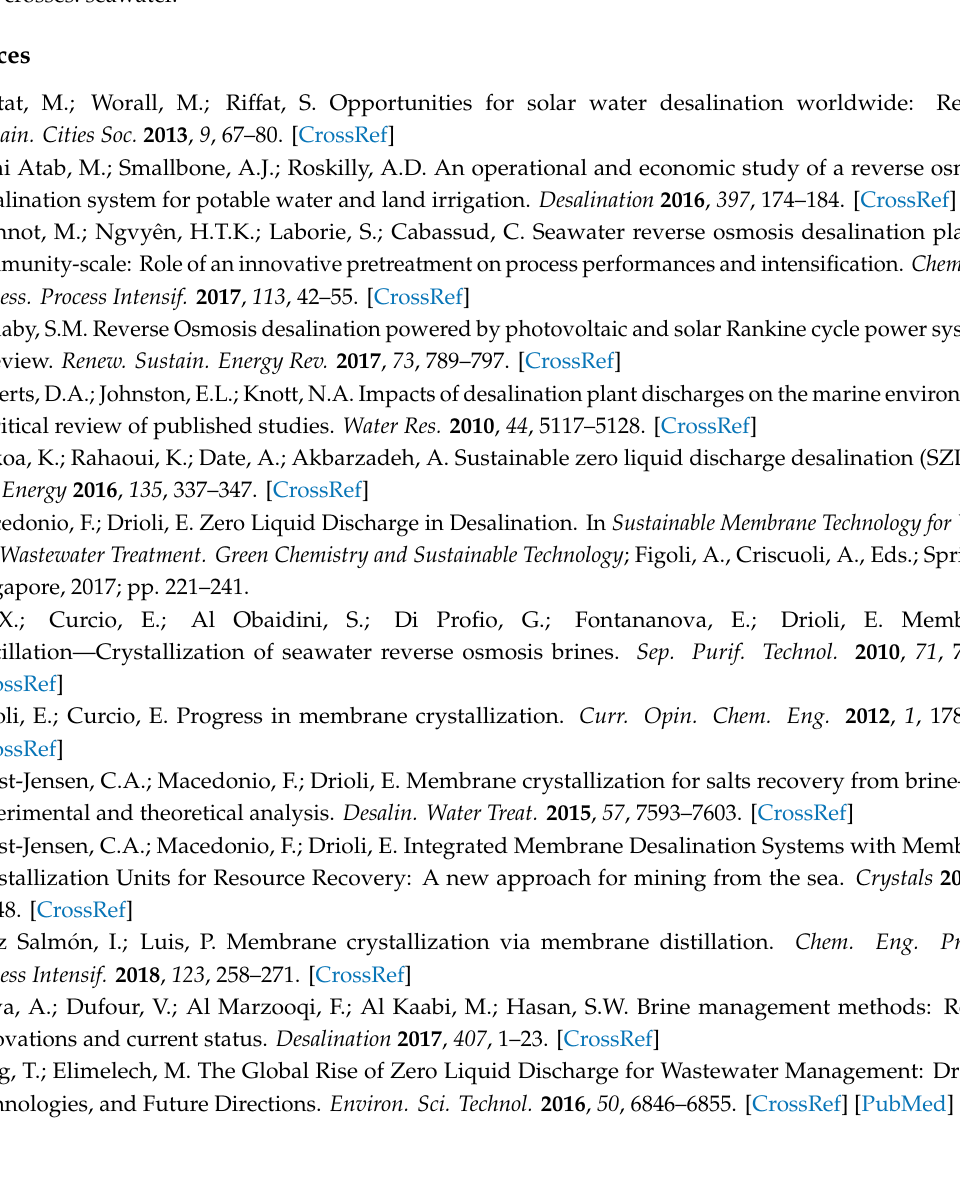
Figure A1. Salt concentration as a function of electrical conductivity. Blue dots: NaCl aqueous solution. Red crosses: